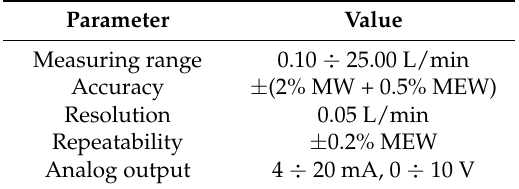
Table 1. Magnetic-inductive flow meter parameters used in the comparison experiment [40].